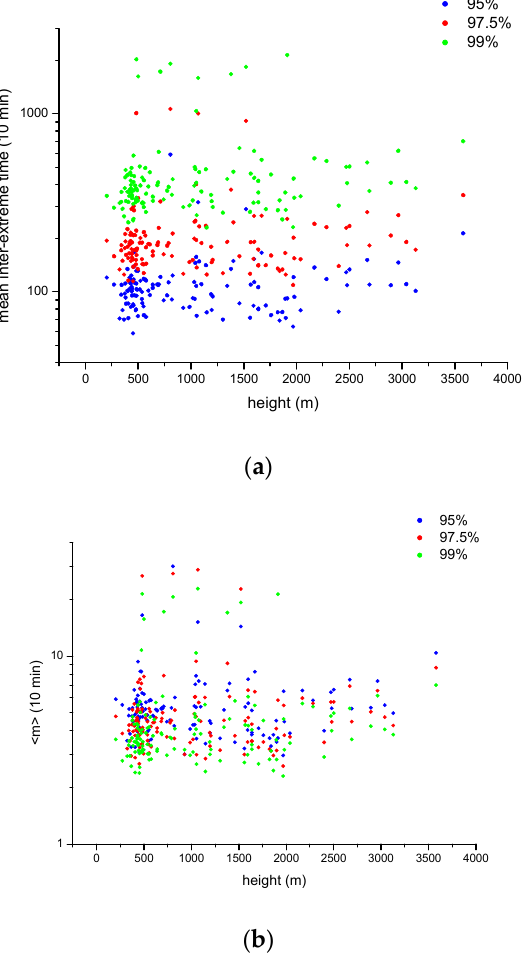
Figure 4. Relationship of ( a ) mean inter-extreme time and ( b ) mean duration with height across the stations.